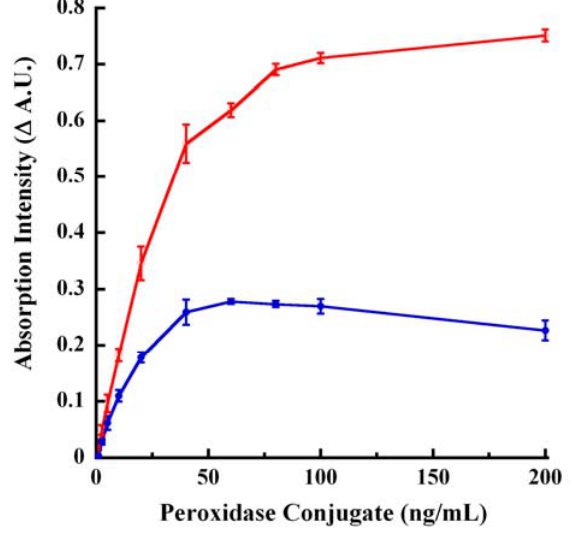
Figure 9. Peroxidase dose-response tracings for CA endpoint mode oxidation. Increasing and indicated concentrations of peroxidase conjugate were reacted with CA for 30 minutes at ~25 °C in 96-well UV-Vis microplate. The reaction was stopped by adding 100 mM NaOH. The red tracing represents Δ A.U. obtained from B − S absorption at 295 nm. The blue tracing represents Δ A.U. obtained from S − B absorption values of 260